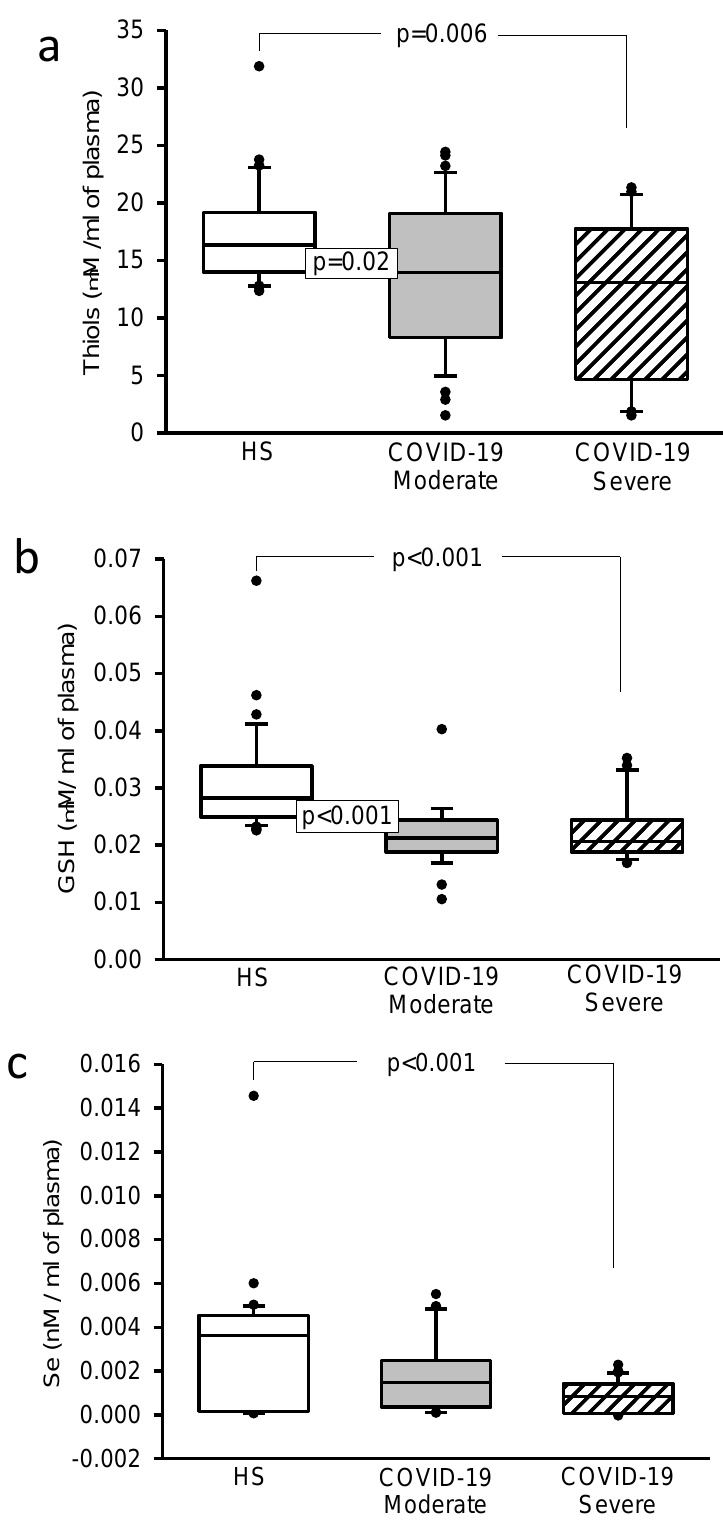
Figure 5. ( a ) The thiol concentrations significantly decreased in the moderate and severe COVID-19 patients in comparison to HS. ( b ) GSH concentration statistically decreased in the moderate and severe COVID-19 patients in comparison with HS. ( c ) The Se concentration significantly decreased in both the moderate and severe COVID-19 patients in comparison with HS. Abbreviations: HS = healthy subjects, GSH = glutathione, Se = selenium.